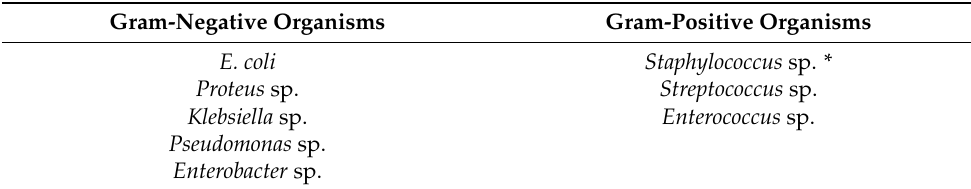
Table 10. Most common bacterial uropathogens accounting for 93% of all canine and feline UTIs according to J. A. Barsanti